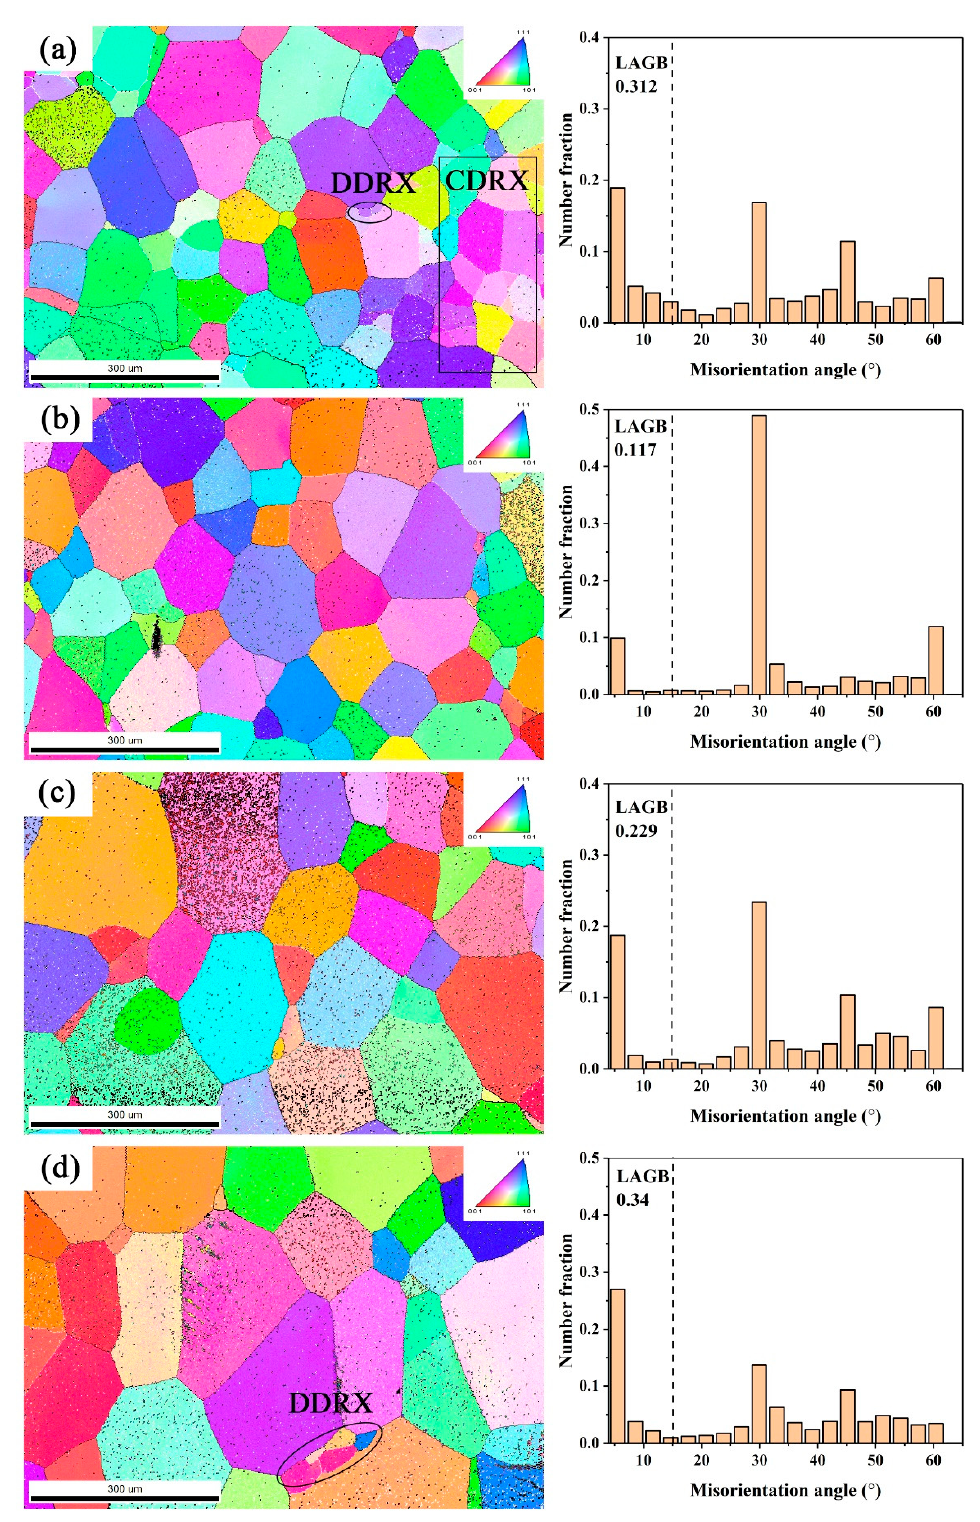
Figure 8. EBSD figures of samples after secondary-pass compression at 950 °C with 0.02 strain with the first-pass deformation temperature of ( a ) 700 °C, ( b ) 750 °C, ( c ) 800 °C, ( d ) 850 °C.